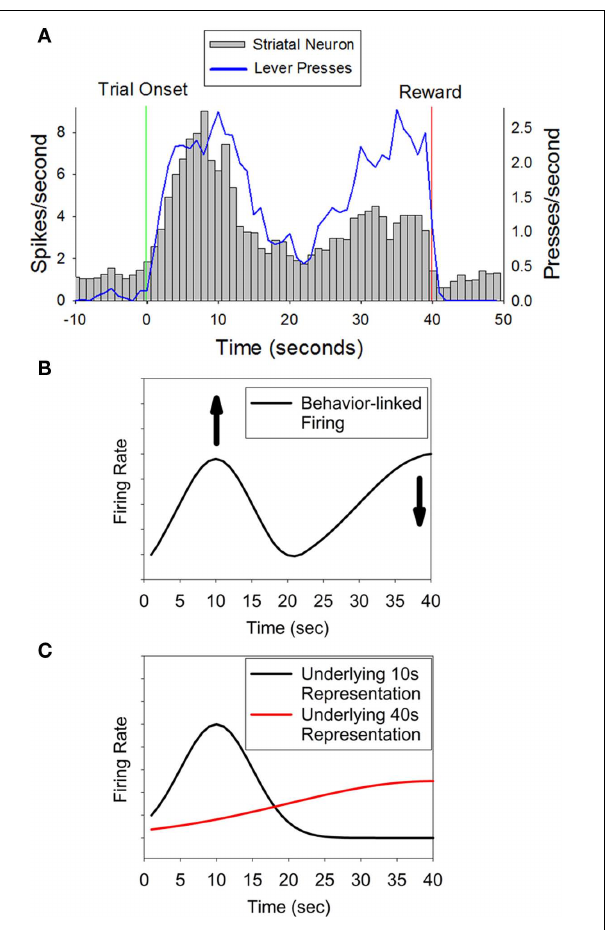
FIGURE 1 | Panel (A) (adapted from Matell et al., 2003) displays the activity pattern of a representative striatal neuron showing differential activity at two times associated with possible reinforcement (10 and 40s), indicating sensitivity to specific temporal interval(s). Importantly, the behavioral response rate was equivalent at these two times, thereby ruling out a simple motor coding role of the striatum.The peak in firing at 10s and the secondary increase in firing at 40s could result from two processes. (B) Represents a temporally modulated motor coding scheme in which the neural activity is directly tied to the motor behavior of the rat, but firing is enhanced at 10s, and/or diminished at 40s, thereby demonstrating temporal expectation. (C) Represents an “abstract” temporal coding scheme, such that both 10 and 40s are represented by the neuron, and the smaller magnitude at 40s reflects scalar variability. In this latter coding scenario, the motor behavior of the rat is a “downstream” effect and does not contribute to striatal firing